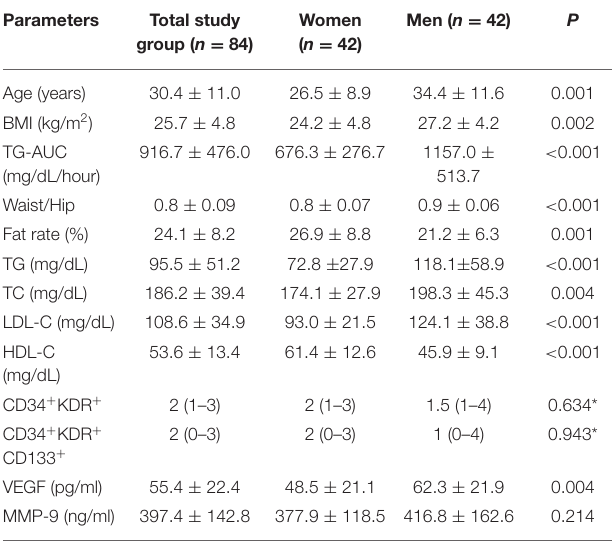
TABLE 1 | Physical characteristics and biochemical and immunological parameters of the subjects at baseline.